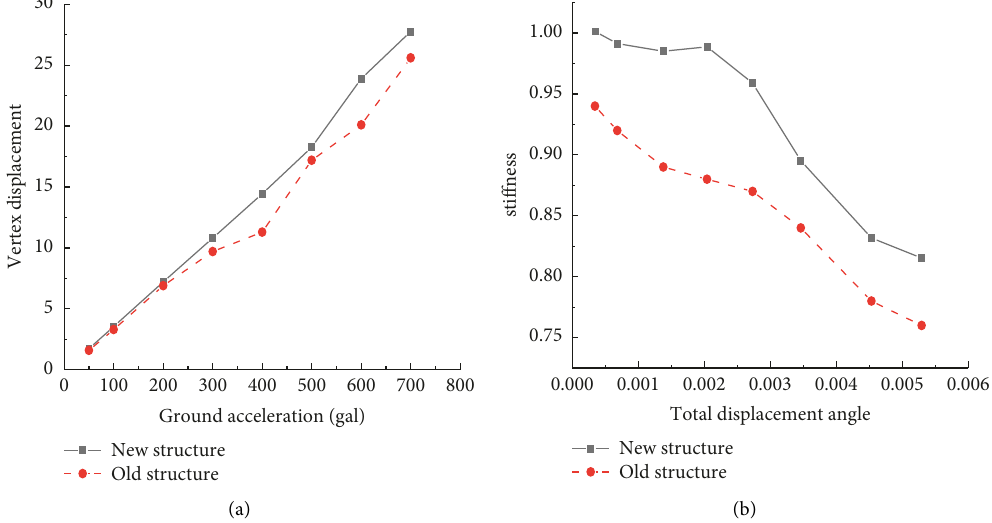
Figure 7: Relationship of total displacement, total displacement angle, and stiffness. (a) The relationship between ground acceleration and vertex displacement; (b) the relationship between total angular displacement and